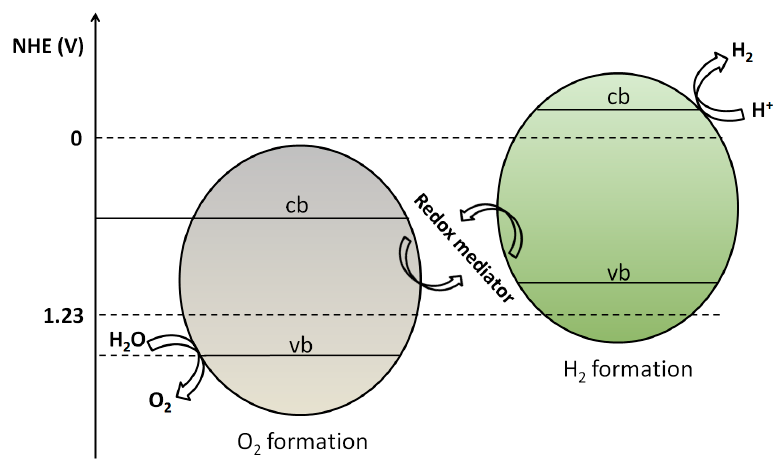
Figure 7. Schematic illustration of the Z-scheme.